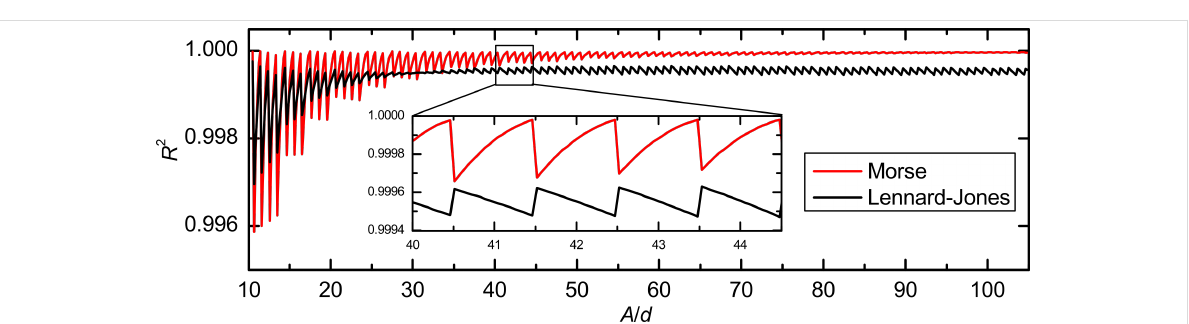
Figure 8: Dependence of the CoD on the ratio A / d of amplitude and step width for the Morse and the Lennard-Jones force law. The inset shows that the spikes are always at positions A / d = n + 0.5 for both force laws with an integer n